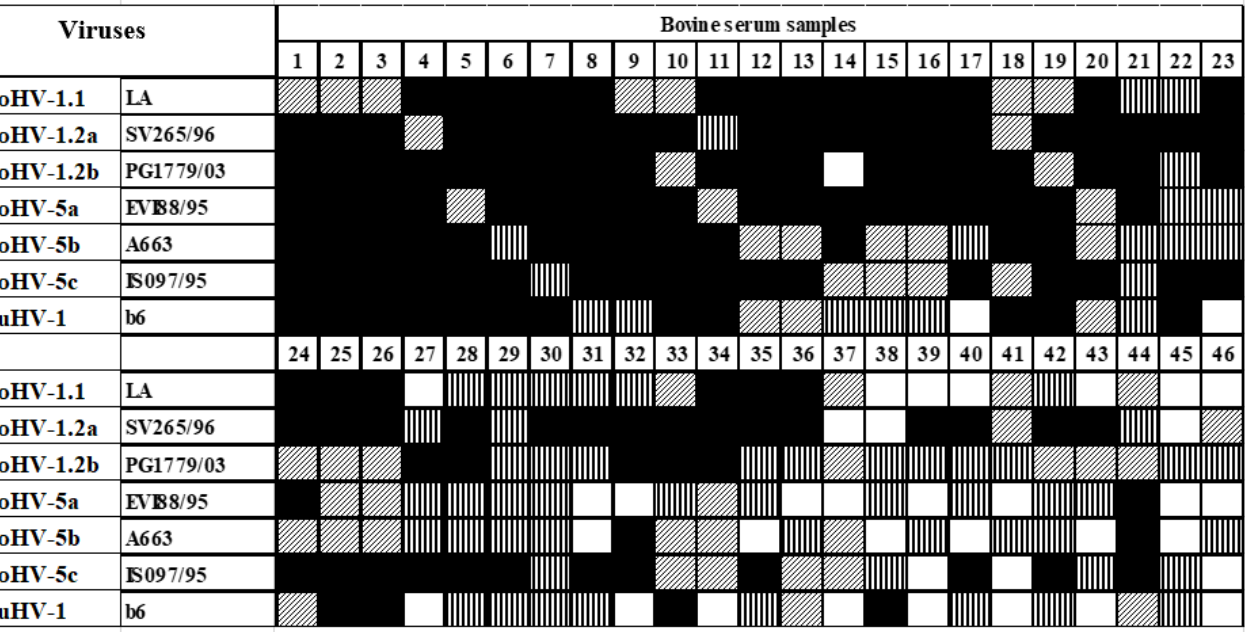
Figure 1. Reactivity profile of neutralizing antibody-positive bovine sera at SN and preparative single antigen ELISAs (sAgELISAs) with seven ruminant alphaherpesviruses as challenge viruses or antigens. Shown only those with discrepant results in any of the assays (n = 46). Black squares: positive reaction to a particular strain in both tests; white squares: negative reaction to a particular strain in both tests; vertical stripes: positive reaction to a particular strain at SN only; diagonal stripes: positive reaction to a particular strain at the sAgELISA only.